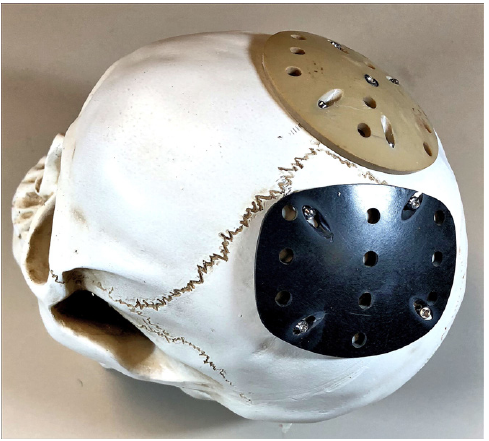
Figure 18: Fixation of PEEK cranial implants onto adult model skull.